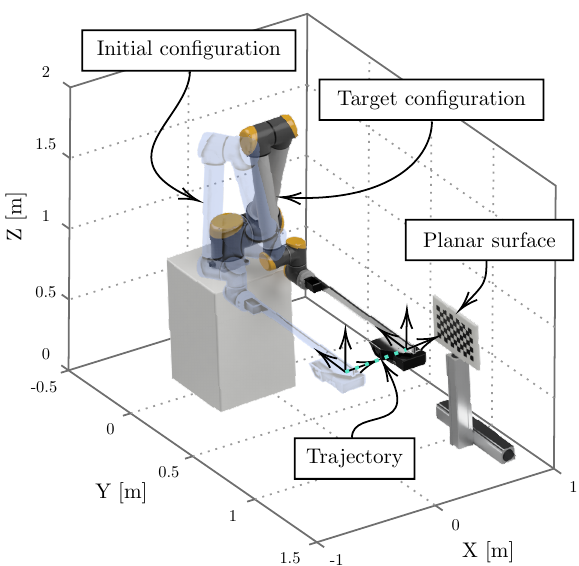
Figure 5: Robot path for the first experiment.